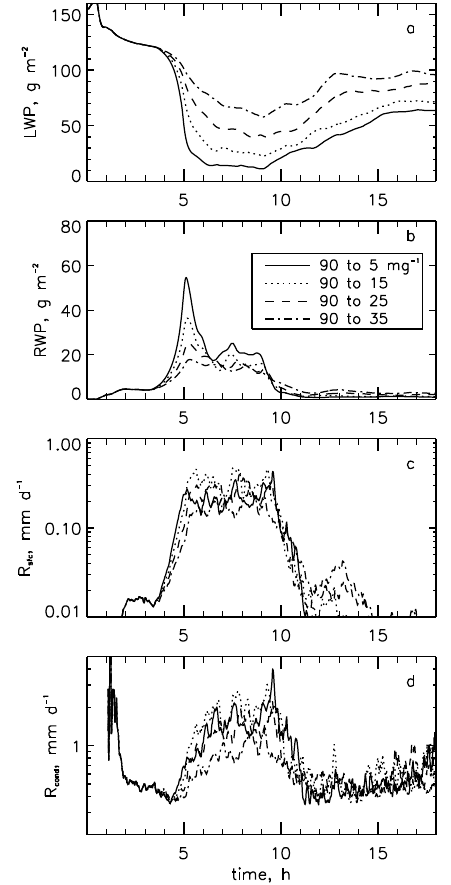
Figure 2. LWP at t = (a) 3h (closed cell), (b) 5h (closed transi- tioning to open), (c) 7h (open cell), (d) 11h (open transitioning to closed), (e) 13h (further recovery to closed), (f) 18h (closed cell). Control simulation with minimum N =5mg − 1 . The grey scale ranges from 0 to 450gm − 2 .